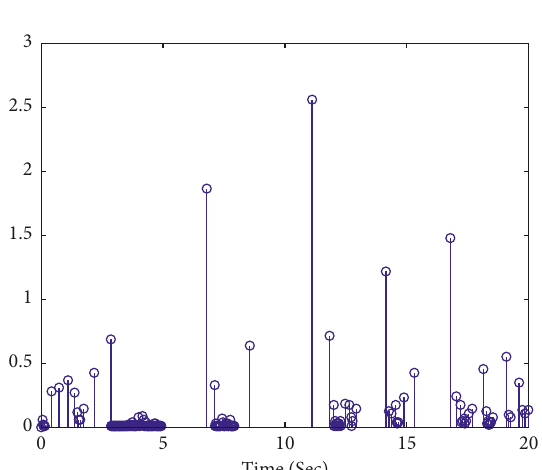
Figure 6: Time interval of each triggered